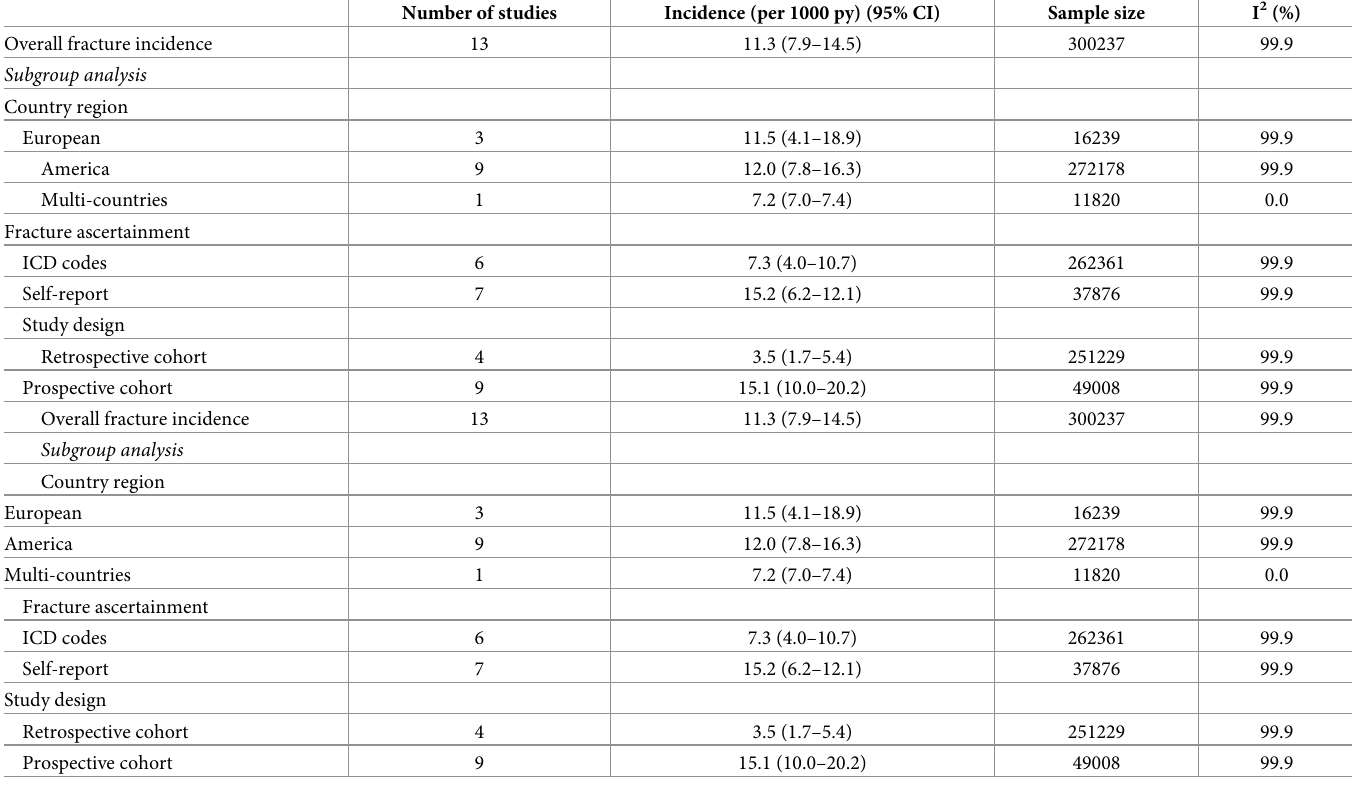
Table 3. Incidence of fracture among people living with HIV by demographic variable in selected studies.